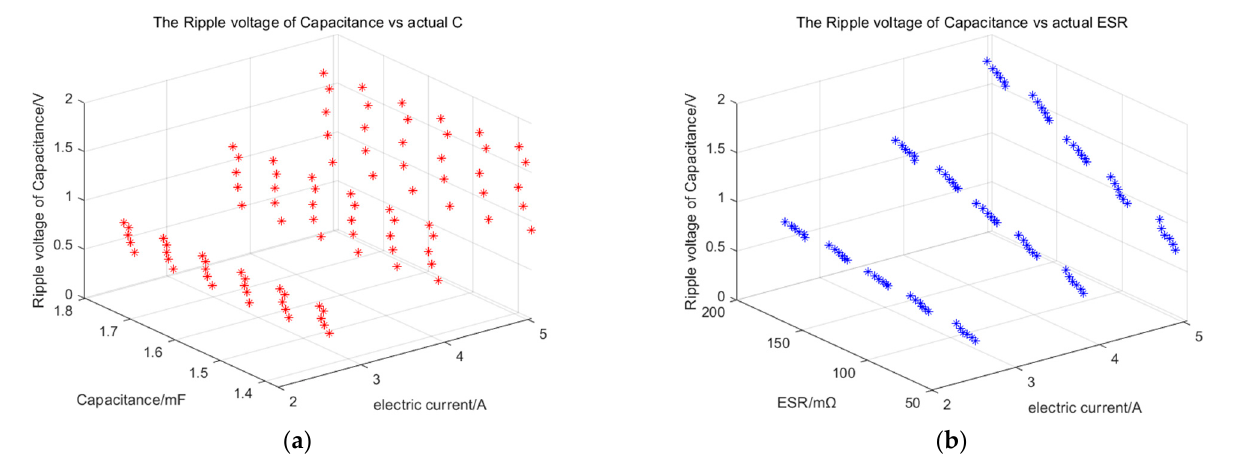
Figure 10. ( a ) The amplitude of 5 kHz component in DC-link voltage vs. actual C; ( b ) The amplitude of 5 kHz component in DC-link voltage vs. actual ESR.